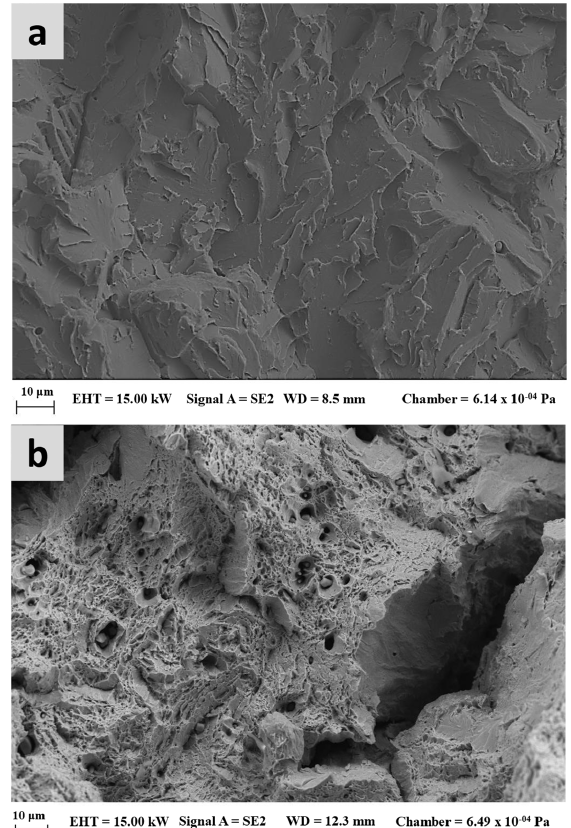
Figure 10. ( a ) Brittle fracture at the core of the untreated specimen. ( b ) Ductile fracture of the tensile specimen with few brittle zones. About nitrided specimens, subsurface nucleation is detected. Figure 11 shows exam- ples of the fracture analysed by stereoscopic instrument (Figure 11a,b) and with SEM (Fig- ure 11c,d), with the typical fish-eye fatigue propagation [7,22]. In all tests, the fish-eye area appears circular and white, with the crack nucleation site as a dark area in the centre. This dark area is known as the “Optically Dark Area” (ODA) by Murakami et al. [23] or as the “fine granular area” (FGA) by Sakai et al. [24] and “Granular-Bright-Facet” (GBF) by Shi- ozawa et al. [25]. Notice that the fatigue propagation is limited to a small portion of the resistant section, about 16%.